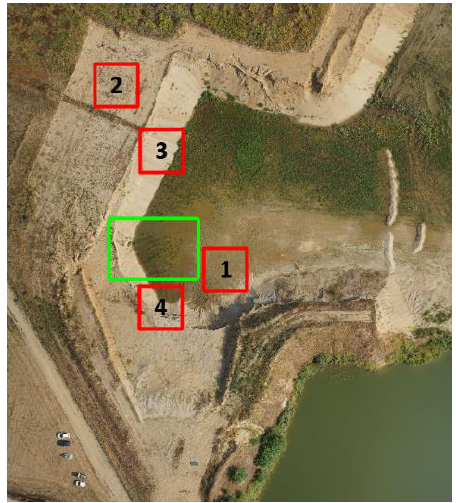
Figure 10. Location of the detailed test